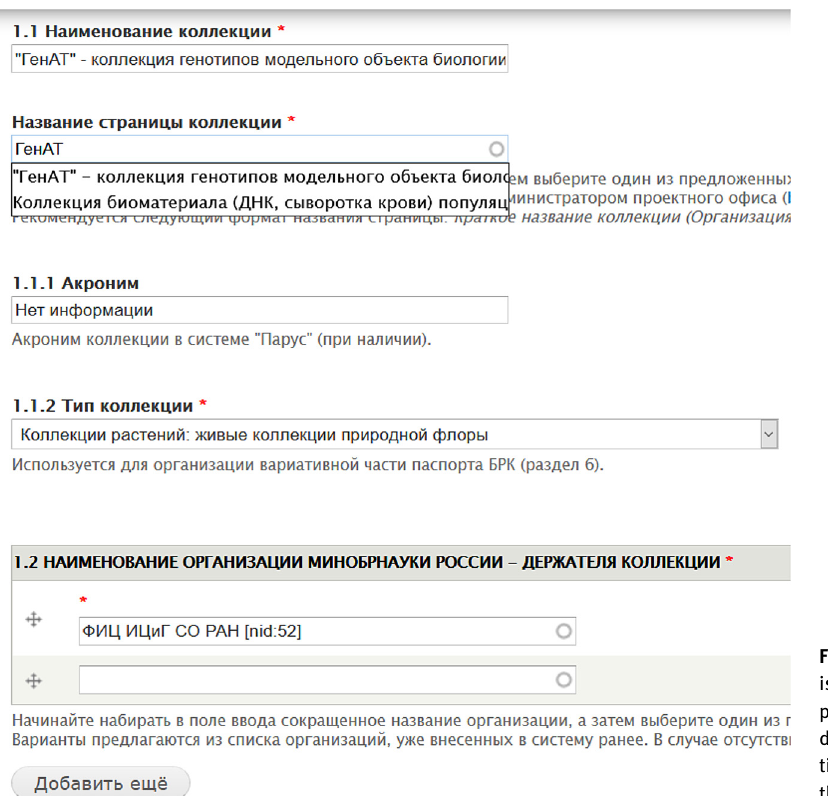
Figure 8: A set of different fields is used in a material creation process – autocomplete fi eld, drop-down list, fi eld with mul- tiple possible values. Some of the fi elds are required